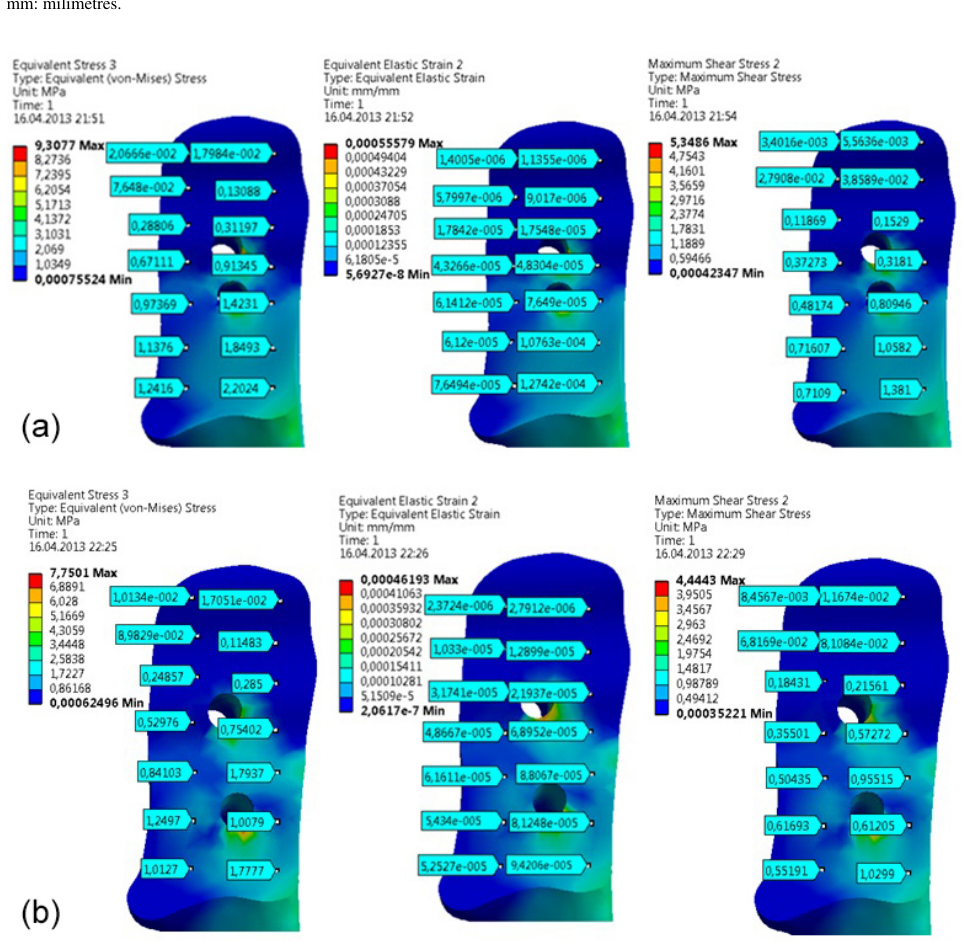
Figure 4. The biomechanical parameters on the distal surface of the fracture line for both